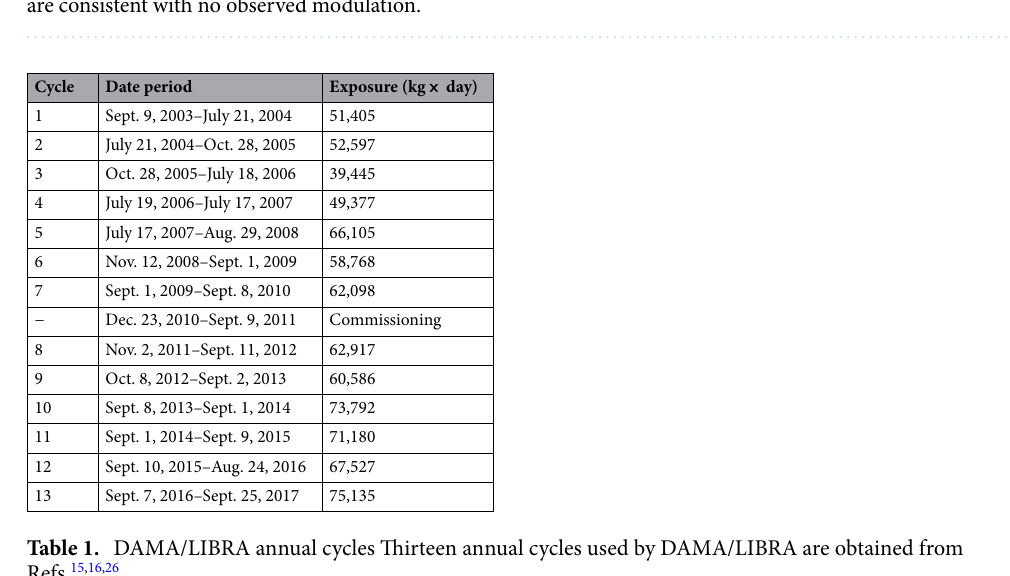
Figure 4. Single-hit event rates in the unit of counts/keV/kg/day as a function of time. The top four panels present time-dependent event rates and the residual rates in the single-hit 1–6 keV regions with 15 days bin. Here, the event rates are averaged for the five crystals with weights from uncertainties in each 15-day bin. Purple solid lines present background modeling with the single exponential ( a ) and the yearly averaged DAMA-like method ( b ). Residual spectra for the single exponential model ( c ) and the DAMA-like model ( d ) are fitted with the sinusoidal function (red solid lines). Same for 2–6 keV in the bottom four panels. Strong annual modulations are observed using the DAMA-like method while the result using the single-exponential models are consistent with no observed modulation.